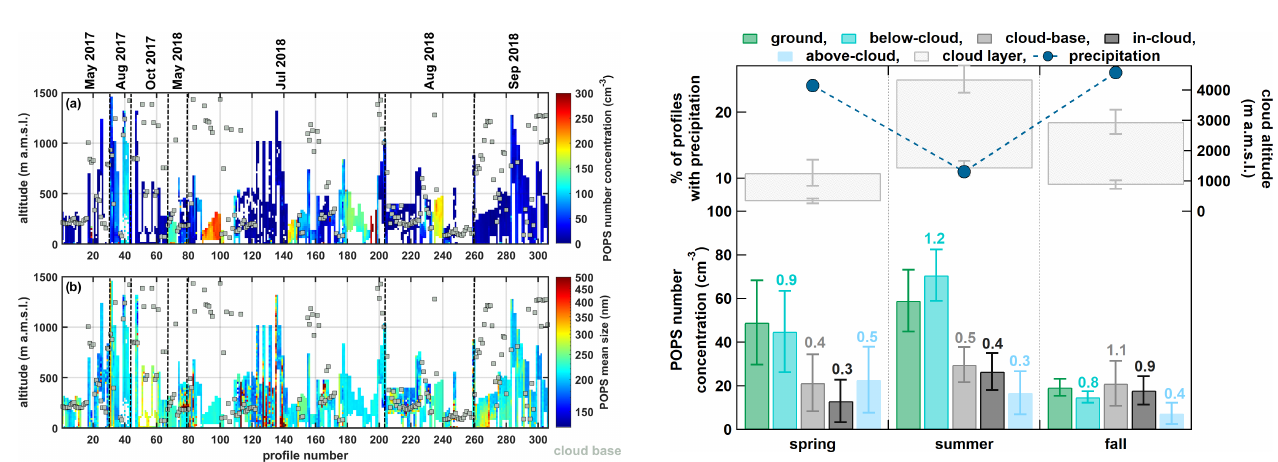
Figure 5. Image plots of POPS (a) total number concentration and (b) mean particle size during all profiles from the TBS deployments plotted by altitude. The color scales represent number concentration and mean size, respectively. White regions indicate no data were ob- tained. The grey markers represent mean cloud base height during each profile. Profiles without cloud base shown either do not have cloud base data or have a cloud base above 1.5kma.m.s.l.